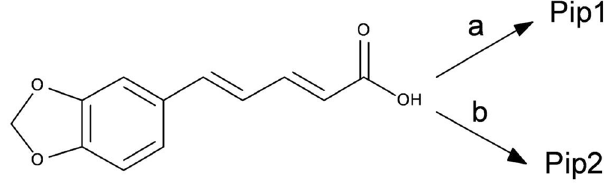
Figure 5. Synthesis of piperine analogs. ( a ) 6,7-Dimethoxy-1,2,3,4-tetrahydro-isoquinoline, isobutyl chloroformate, N-methylmorpholine, THF, 0 °C to rt, 25%. ( b ) 2-(3,4-Dimethoxy-phenyl)-ethylamine, isobutyl chloroformate, N-methylmorpholine, THF, 0 °C to rt,